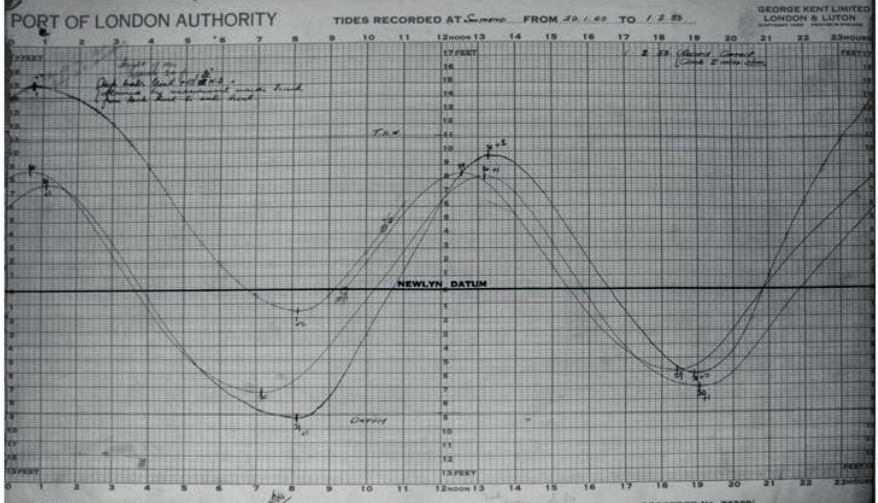
Fig. 3 Example of an analogue tide gauge